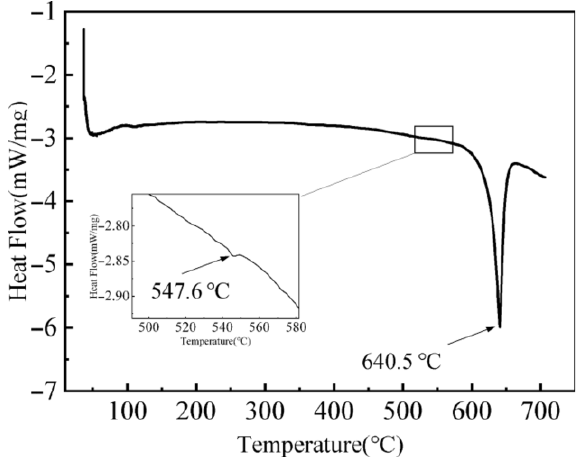
Figure 2. DSC curve of as-cast Mg-3Y-4Nd-2Al alloy.